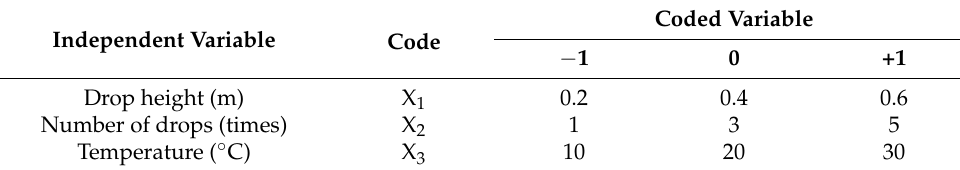
Table 3. Coded independent variables of drop height, number of drops, and storage temperature for RSM with central composite face-centered design